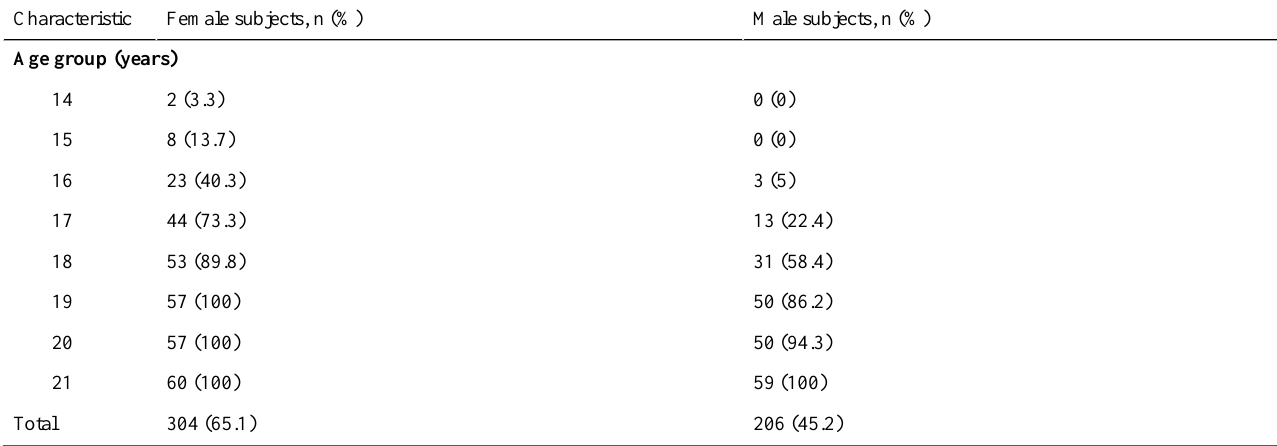
Table 5. Numbers and percentages (over each age group) of subjects with all of the growth plates in stage 5, for male and female subjects.